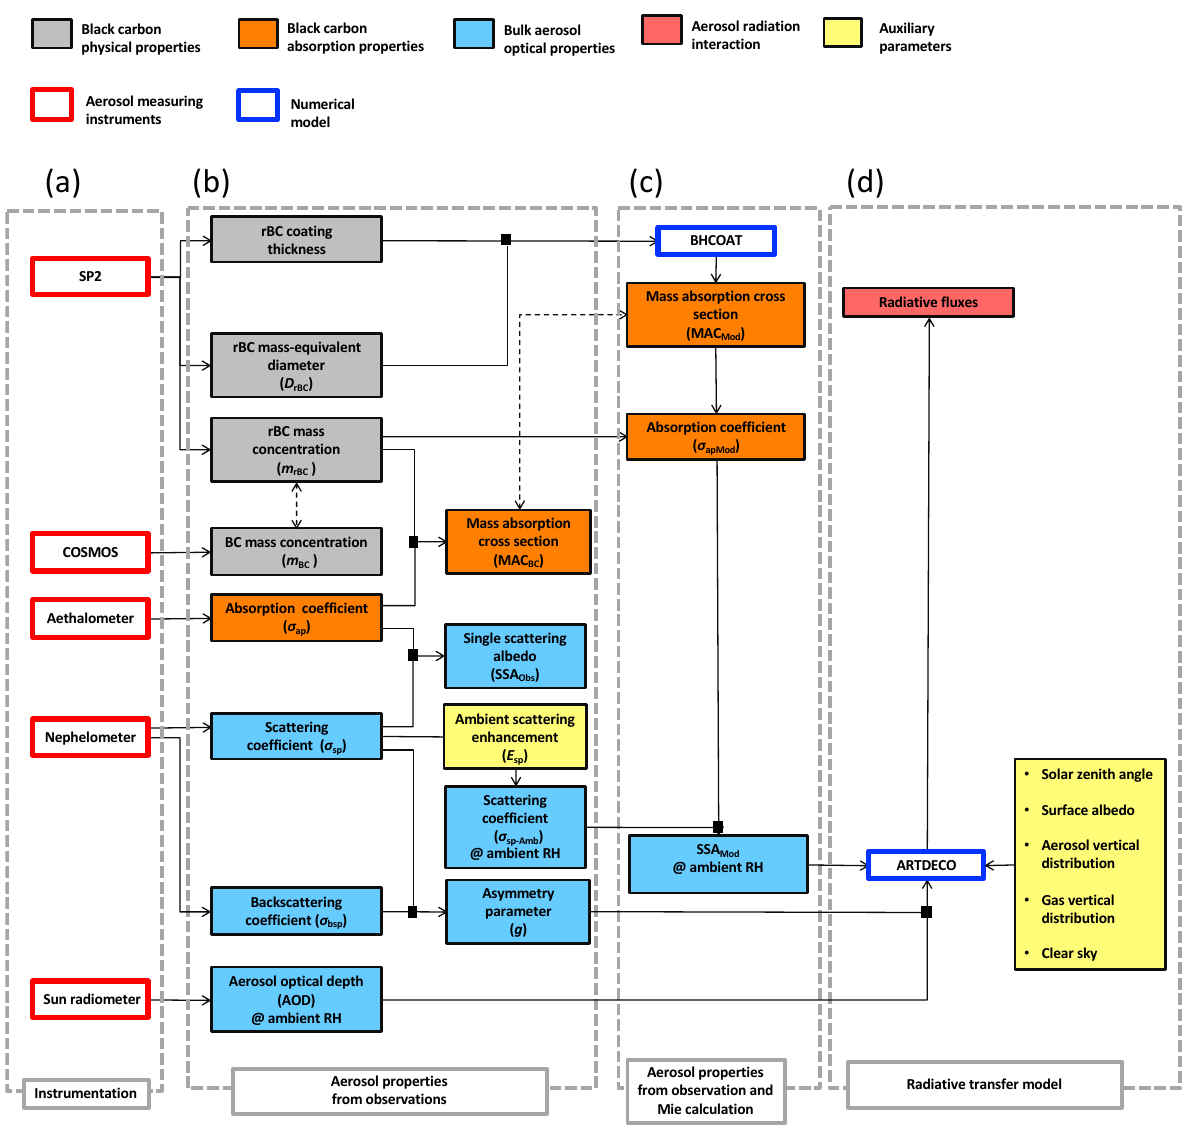
Figure 1. Flow chart from observations to radiative forcing: (a) deployed instruments; (b) observed properties; (c) properties obtained from optical model constrained by observations; (d) radiative transfer model simulations. Measurements and quantities are generally for low RH (“dry”), unless “@ ambient RH” is explicitly